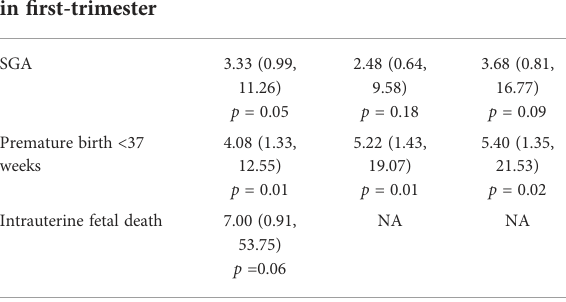
TABLE 3 Univariate and multivariate logistic regression analyses of thrombocytopenia in fi rst-trimester associated with adverse pregnancy outcomes in patients with